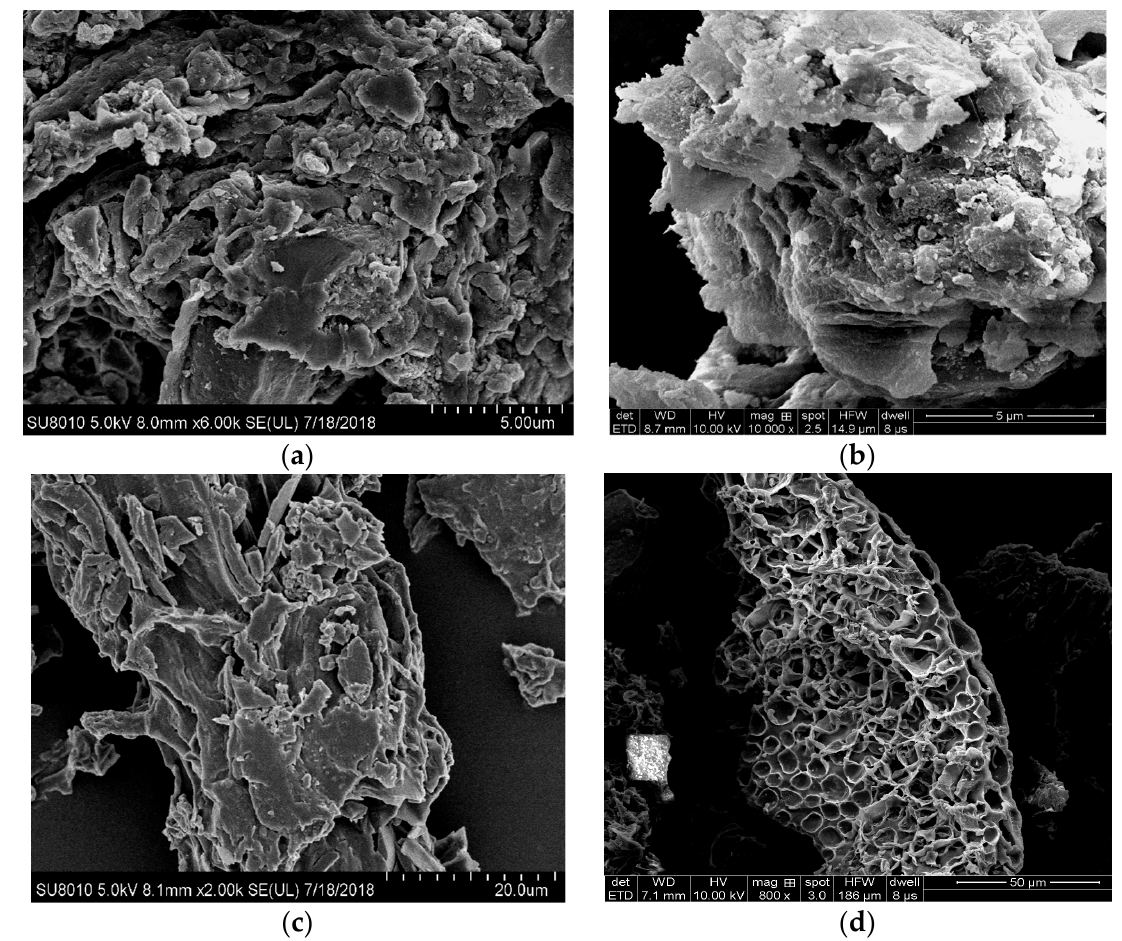
Figure 3. SEM images of ( a ) MSB300, ( b ) MSB500, ( c ) PLB300, and ( d ) PLB500. With pyrolysis temperatures from 300 to 600 °C, the pH of the biochars increased from 7.4 ± 0.2 to 10.1 ± 0.1, from 7.3 ± 0.1 to 9.6 ± 0.1 for MSB and PLB, respectively. It proved a significant positive correlation between pH value and pyrolysis temperature [13]. The EC of PLB increased from 1.35 ± 0.04 mS/cm at 300 °C to 1.64 ± 0.07 mS/cm at 600 °C, while it decreased from 1.75 ± 0.03 mS/cm to 0.76 ± 0.02 mS/cm with pyrolysis temperatures increasing from 300 °C to 600 °C for MSB.